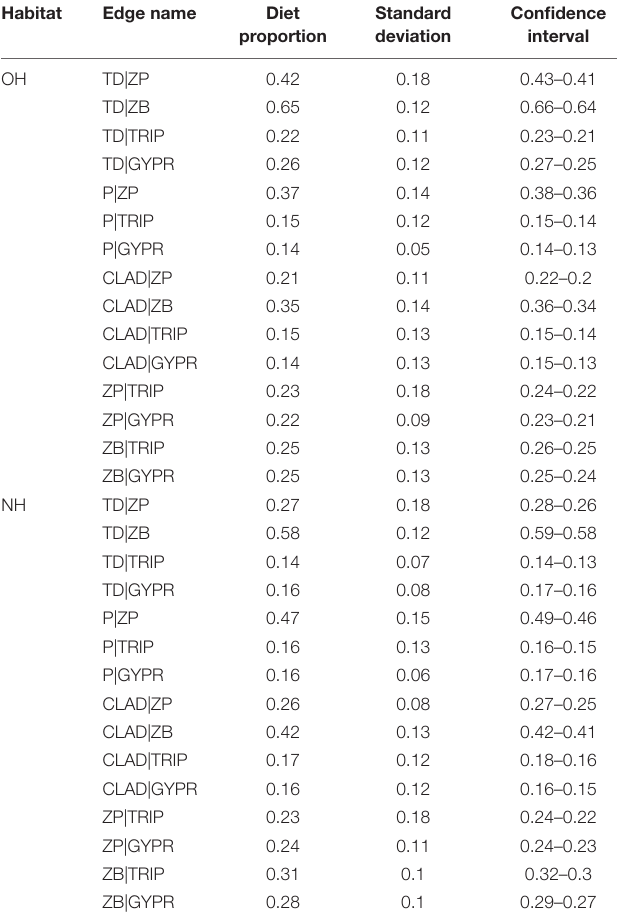
TABLE 1 | Bayesian isotope mixing model estimates of diet proportions for consumers in original (OH) and new (NH) habitats.